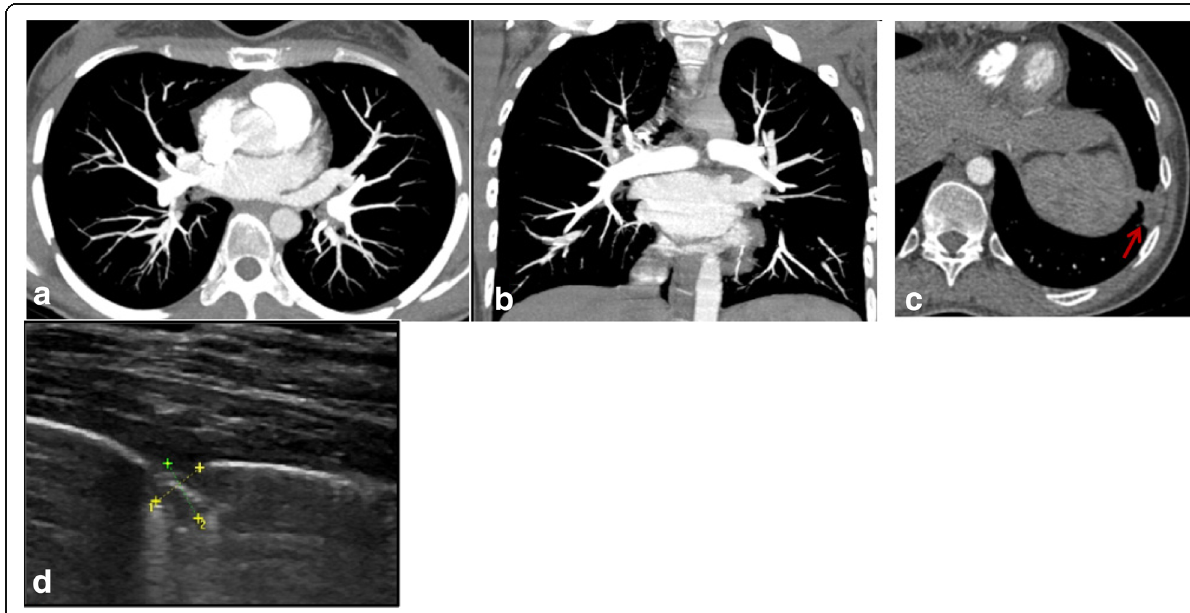
Fig. 7 CT pulmonary angiography ( a – c ) and ultrasound ( d ) images. a , b Axial and coronal sections in the mediastinal window showing normal appearance of the main, segmental, and the sub-segmental arteries with no evidence of any filling defects. c An axial section showing a left basal pleural-based subsegmental atelectasis ( red arrow ). d An ultrasound image in B-mode showing a left lower lung zone well-defined pleural-based rounded hypoechoic lesion (between the